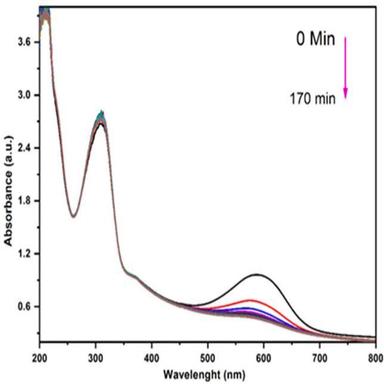
The photocatalytic reaction of MTZ - ZnMoO4nanocomposite (40.0 mg) via methylene blue (1.0 ×10− 4 M) degradation in the presence of light and air at 581 nm wavelength.